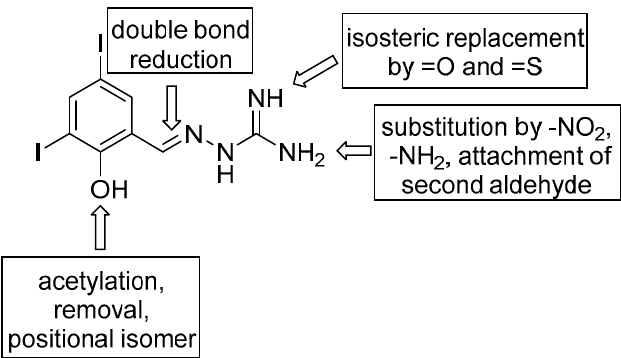
Figure 3. Design of 3,5-diiodosalicylidene-AG 1m analogues.